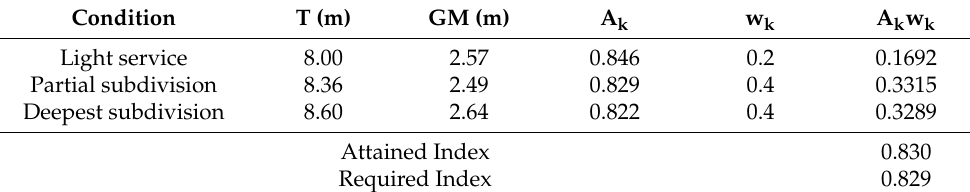
Table 5. Attained index calculations for cruise ship C1 with original